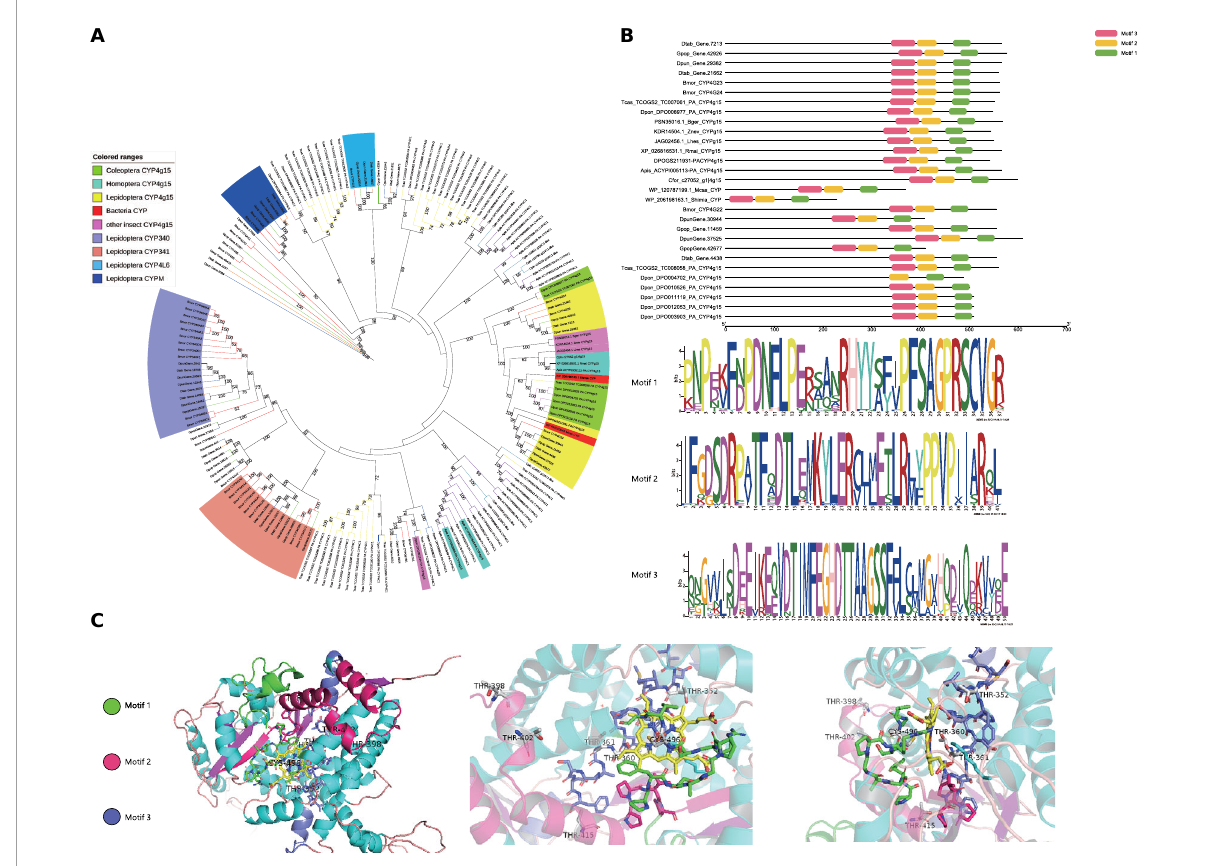
FIGURE2 (A) Maximum-likelihood phylogram of CYP4 subfamily. Gastropacha populifolia (blue branch), Dendrolimus punctatus (green branch), Dendrolimus tabulaeformis (orange branch), Bombyx mori (red branch), Acyrthosiphon pisum (purple branch), Cinara pinitabulaeformis (light blue branch), Tribolium castaneum (yellow branch), Dendroctonus ponderosae (pink branch), and other insects are marked with black branches. (B) Motif prediction of D. punctatus and G. populifolia CYP4g15 by MEME, and three motifs were predicted in CYP4g15. (C) 5t6q.pdb, 6c93.pdb, and 6c94.pdb crystals were used as templates to predict the 3D model of CYP4g15. The overall structure of CYP4g15 is shown on the left, the front diagram of HEM in the middle, and the profile diagram of HEM on the right, and the highly conserved sites of amino acids in the middle and right graphs are represented by stick